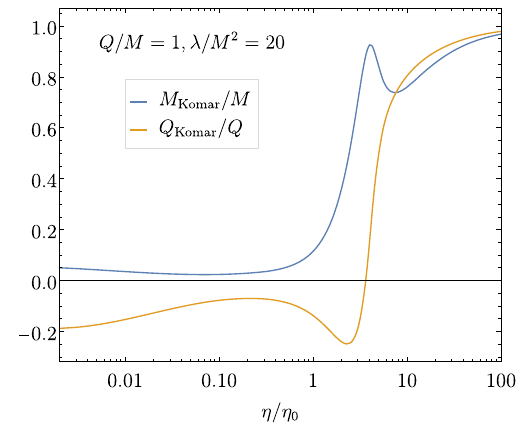
Fig. 6 Same as Fig. 5 for Q / M = 1 and λ/ M 2 = 20